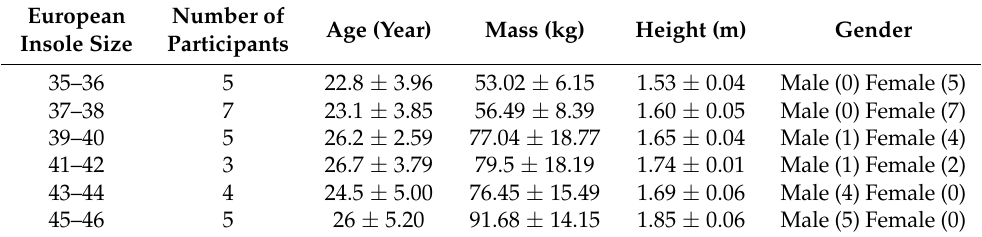
Table 1. Demographic variables of participants.